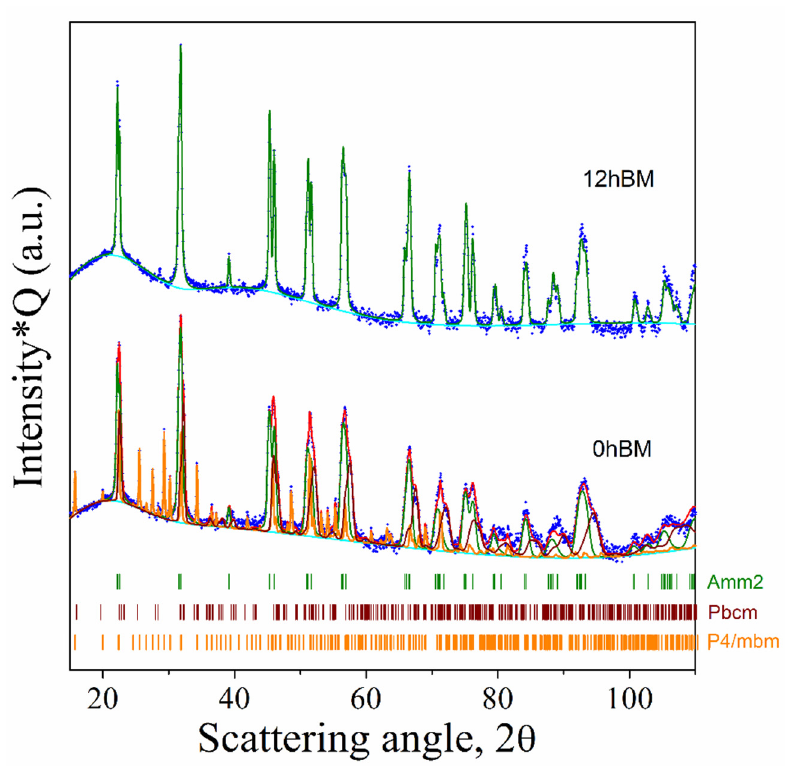
Figure 5. XRD patterns of KNN powders collected from thermogravimetric experiments. The logarithmic intensity is multiplied times Q (2 π /d hkl ) to emphasize the high angle peaks.